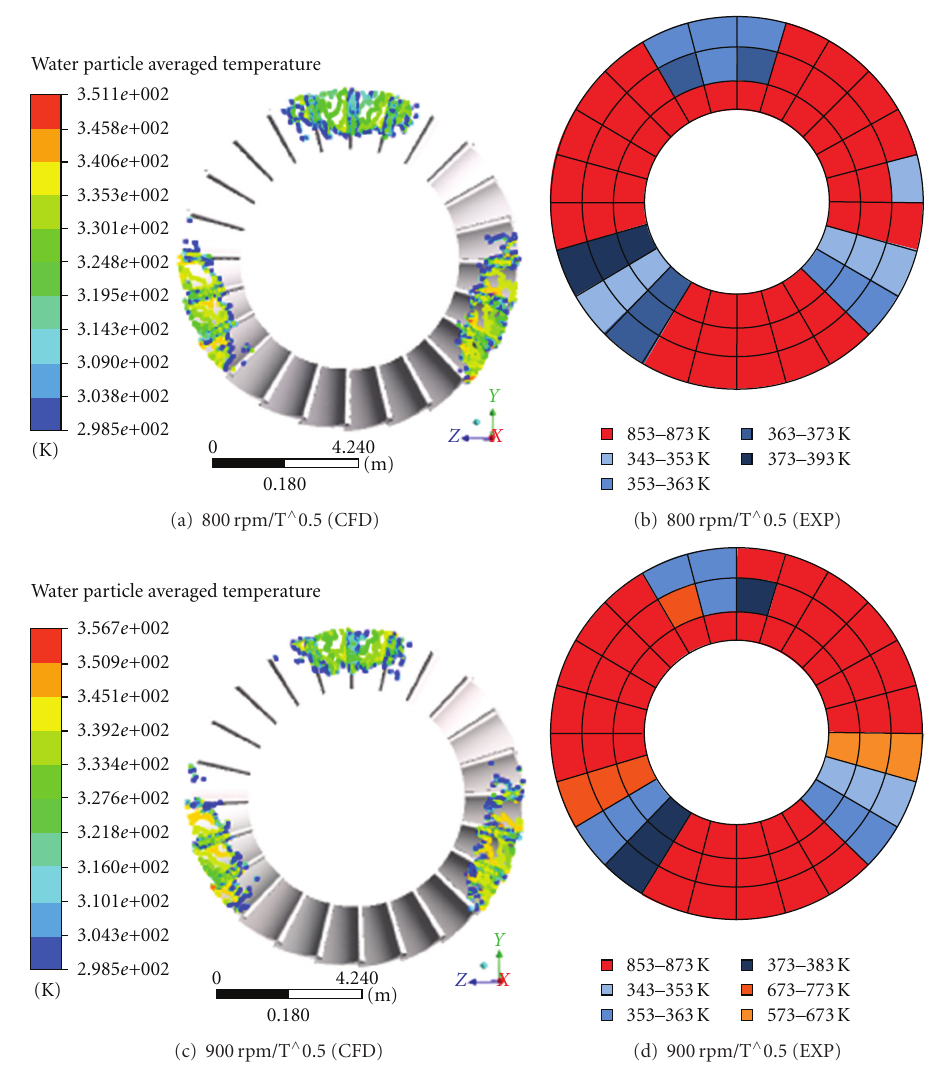
Figure 4: Comparison of water droplet temperature variations at 4 bars on the blade surfaces between numerical predictions (CFD) and experiments (EXP), and 30 ◦ water nozzle